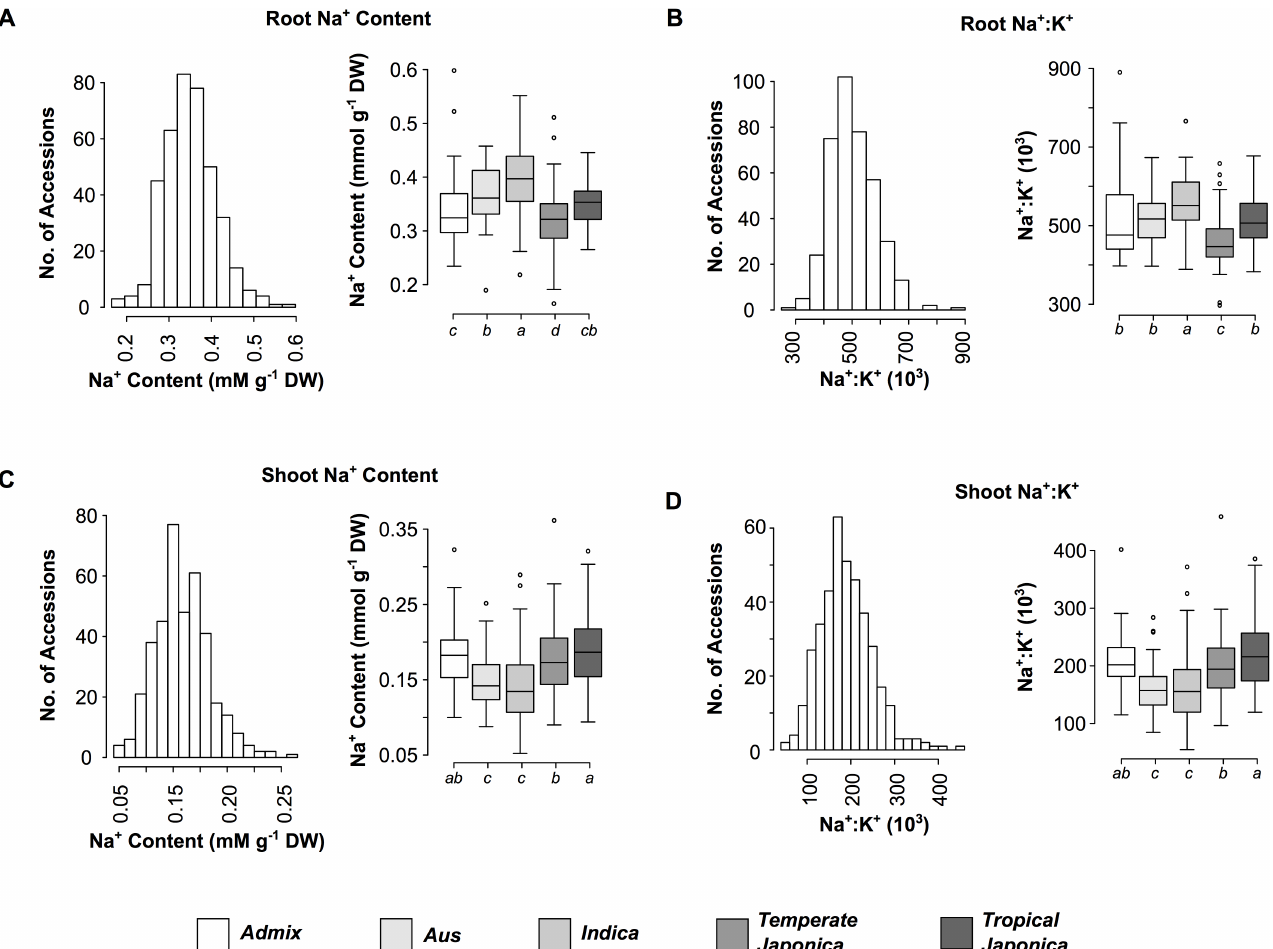
Fig 1. Phenotypic variation and distribution of root and shoot Na + content and Na + :K + among the five subpopulations of RDP1. (A) Root Na + content, (B) root Na + :K + , (C) shoot Na + content, and (D) shoot Na + :K + . Accessionswere assignedto each subpopulationaccordingto Famoso et al [29]. Boxplots with the same letter indicate no significantdifference as determined using ANOVA ( p < 0.05). Aromatic accessions were excluded from the analysisdue to low n .